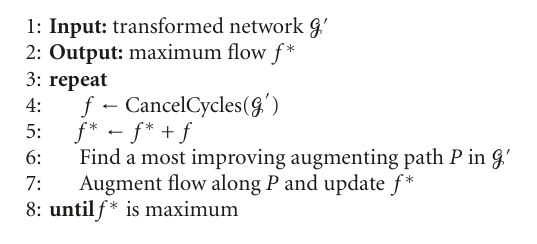
Algorithm 1: Max-flow: most Improving Augmenting